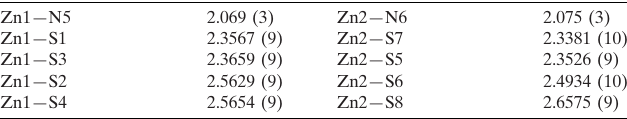
Selected bond lengths (A˚